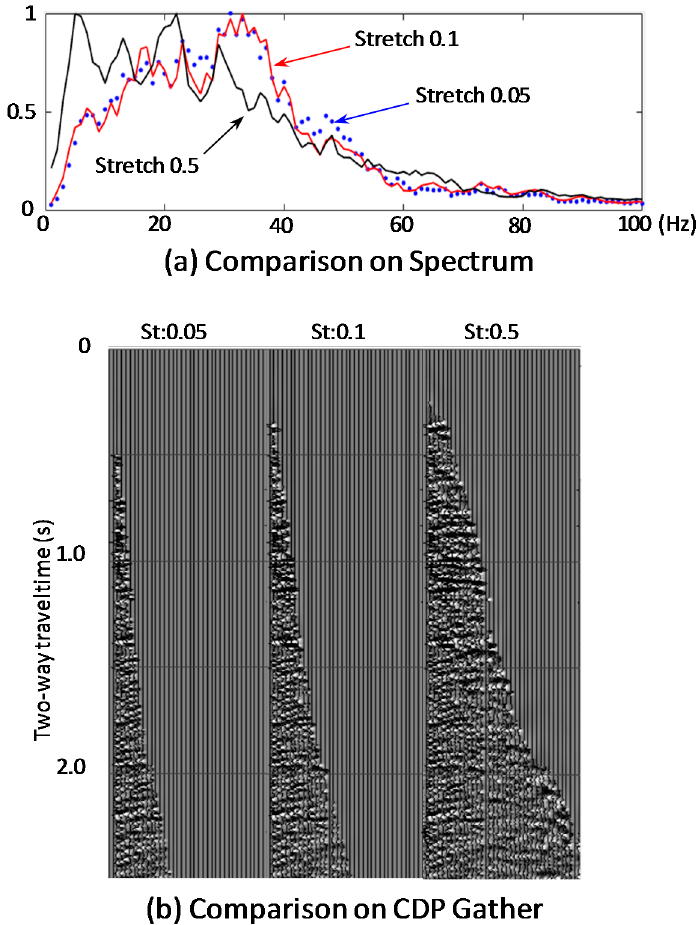
Figure 5. An example of frequency distortion by NMO stretch factor on spectrum ( a ) and CDP gather ( b ). The black solid line, red solid line, and blue dot line in the top figure ( a ) show spectrums from stretch factors of 0.5, 0.1, and 0.05, respectively.